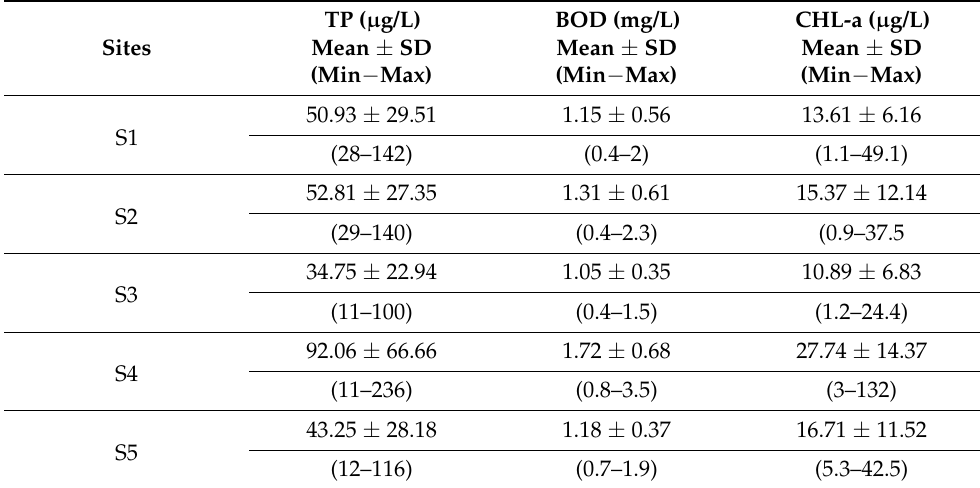
Table 1. Summary statistics of Total Phosphorus (TP), Biological Oxygen Demand (BOD) and Chlorophyll-a (CHL-a) in Paldang Reservoir.